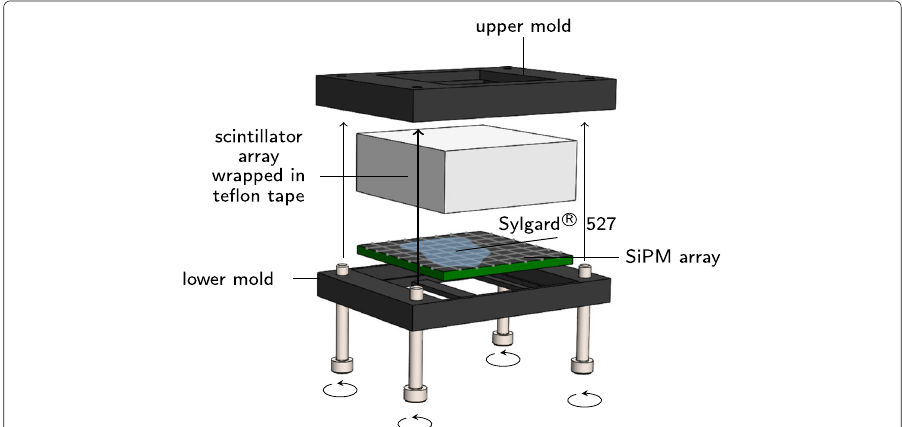
Fig. 3 Assembly tools. Molds used to assemble the detector stacks composed of a segmented scintillator array, a coupling material, and an SiPM array. Each stack was wrapped in teflon tape to prevent light-loss